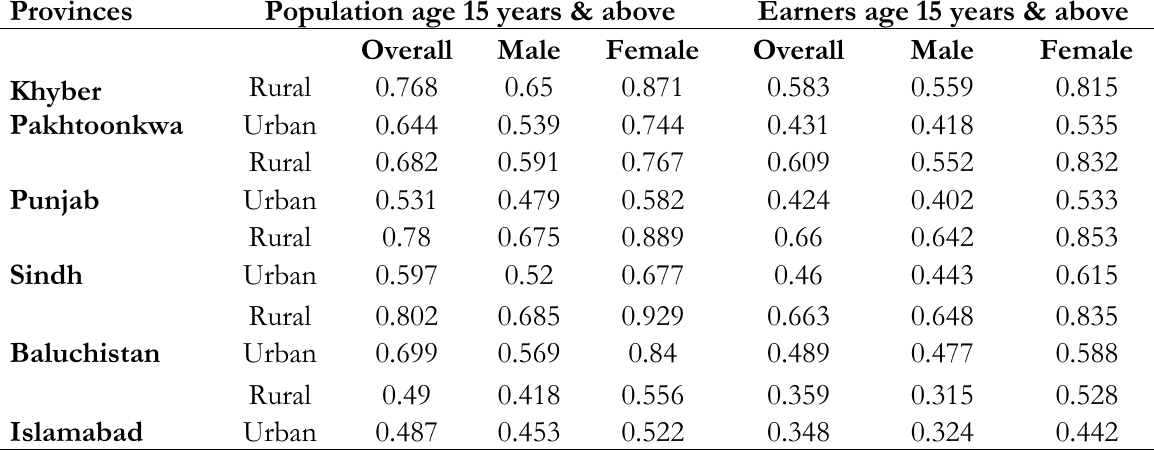
Table 2. Educational Inequalities in Rural and Urban Areas of Pakistan